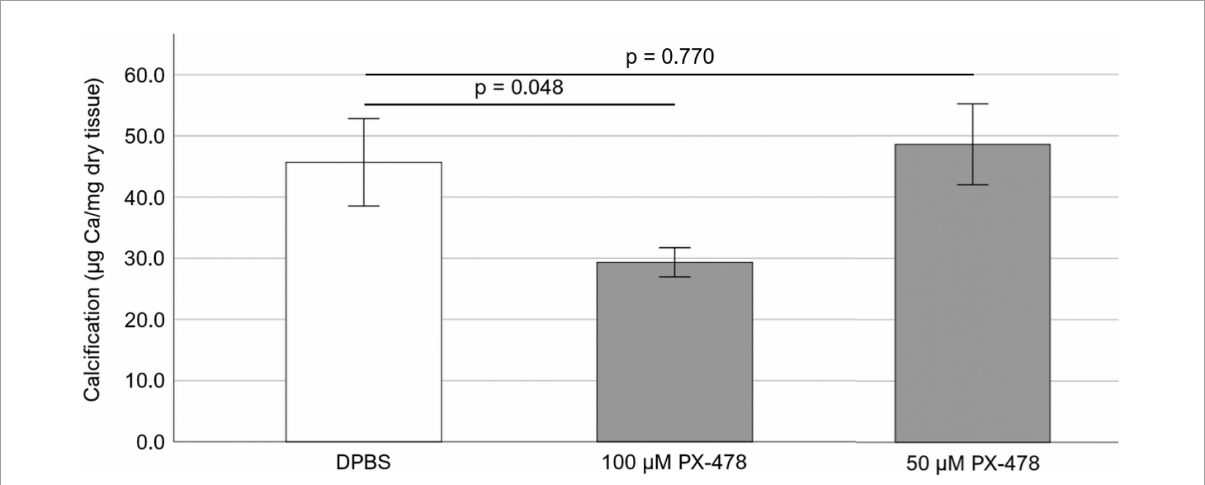
FIGURE2 Effect of 50 and 100 µ M PX-478 on porcine aortic valve (PAV) leaflet calcification after 24 days of 15% stretch in osteogenic medium, as determined by Arsenazo assay ( n =